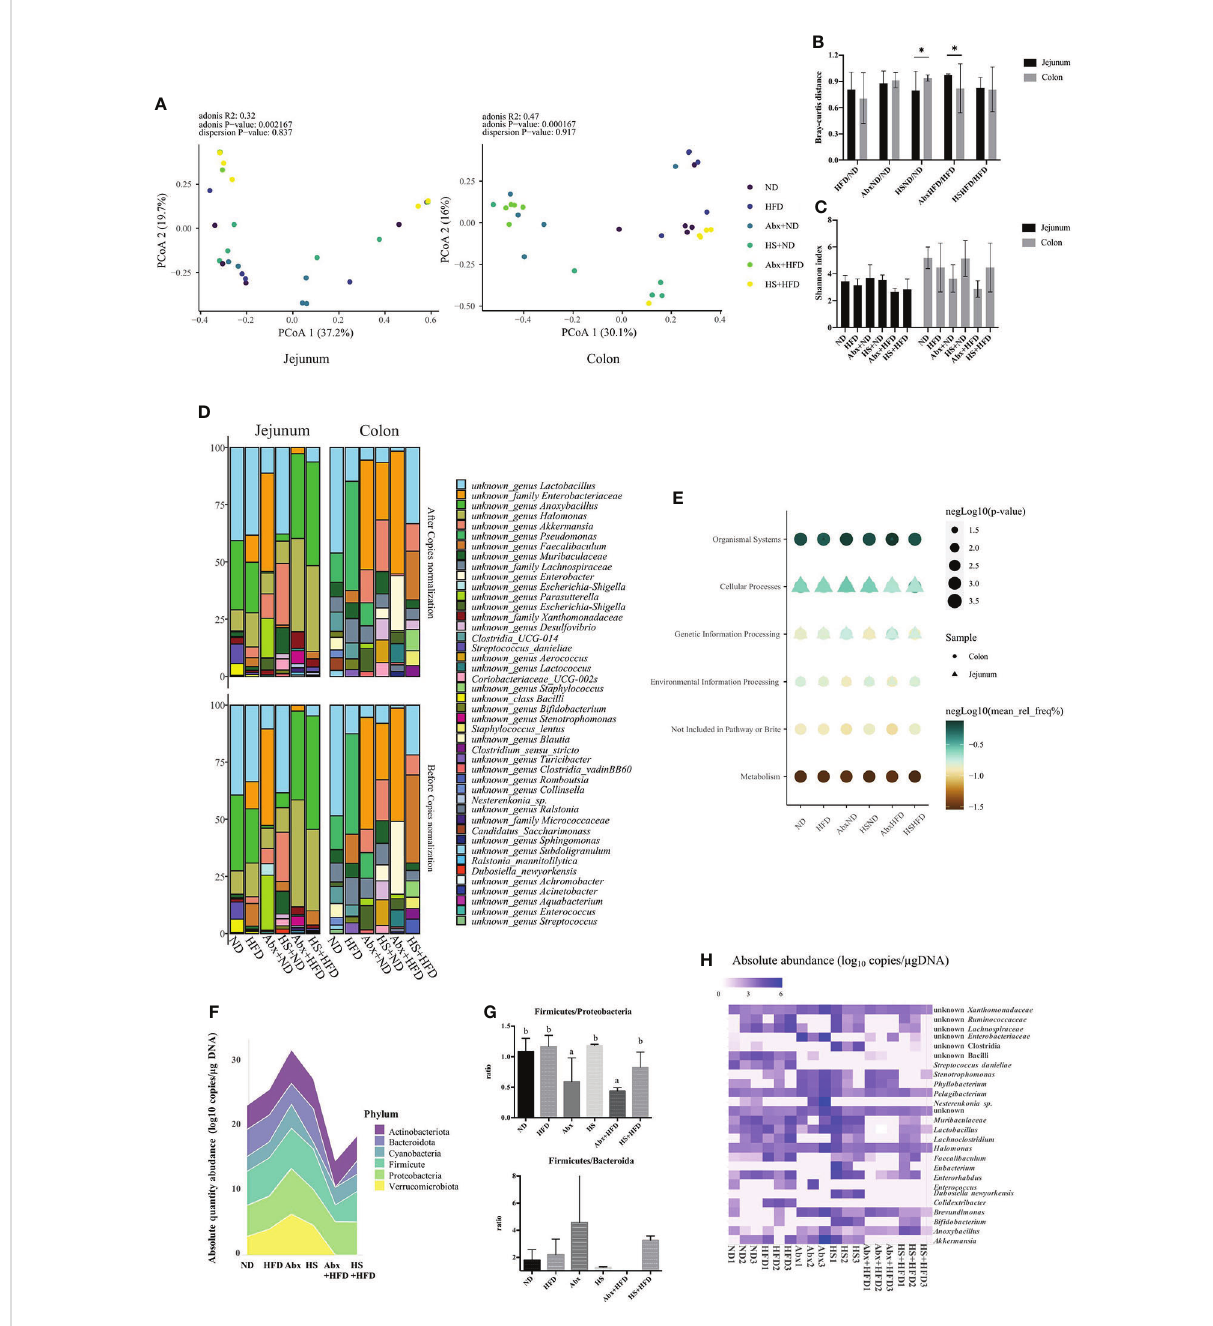
FIGURE 2 Diversity metrics and predicted metabolic pathway of gut microbiota. (A) PCoA analysis for jejunal and colonic microbiota; (B) Bray – Curtis distance between groups; (C) Shannon index. (D) Top 10 taxa identi fi ed. (E) Signi fi cantly different pathway between groups at KEGG Level-1; (F) the absolute abundance of the phylum between group; (G) ratio of Firmicutes to Proteobacteria and Firmicutes to Bacteroidetes; (H) Signi fi cantly different bacteria between groups. (A – E) n = 5 for each group; (F – H) n = 3 for each group, only jejunal microbiota.